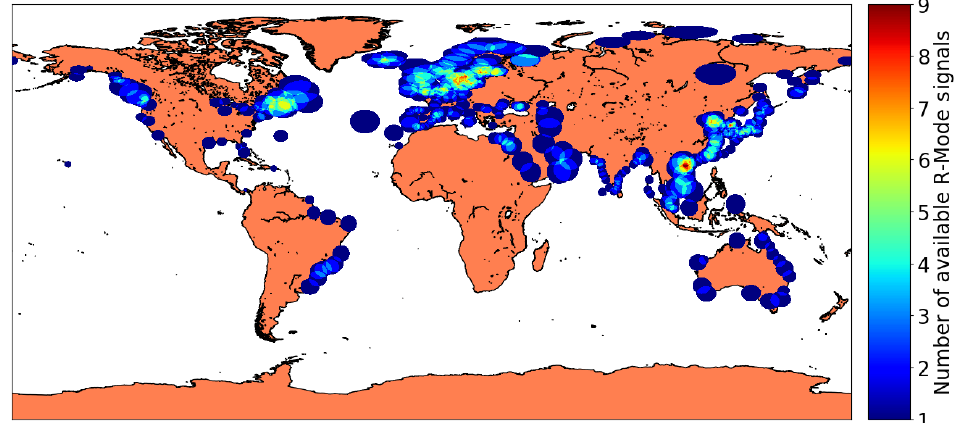
Figure 2. Potential R-Mode service area using radio beacon nominal range. The colors from blue to red indicate the number of available beacon signals in one location. indicate the number of available beacon signals in one